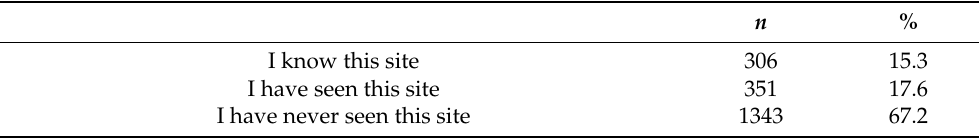
Table 10. The perception of “Information for Consumers Related to COVID-19” published by the